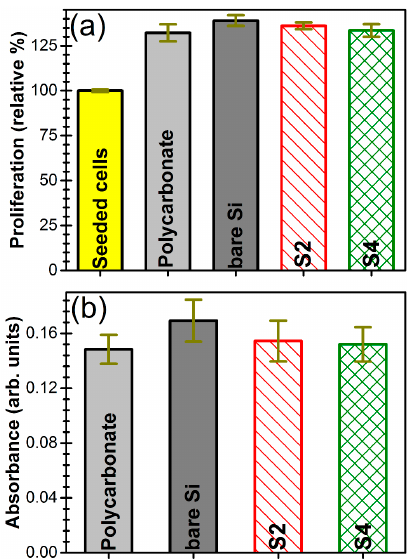
Figure 14. Histograms displaying ( a ) the Hs27 cell proliferation results as obtained by the MTS assay (The MTS values are normalized as the percent to the absorption of the seeding cell number) and ( b ) Cytotoxicity of samples as revealed by LDH assay after 24 h of culturing (The LDH values are presented in arbitrary absorption units, showing the amount of dead cells).